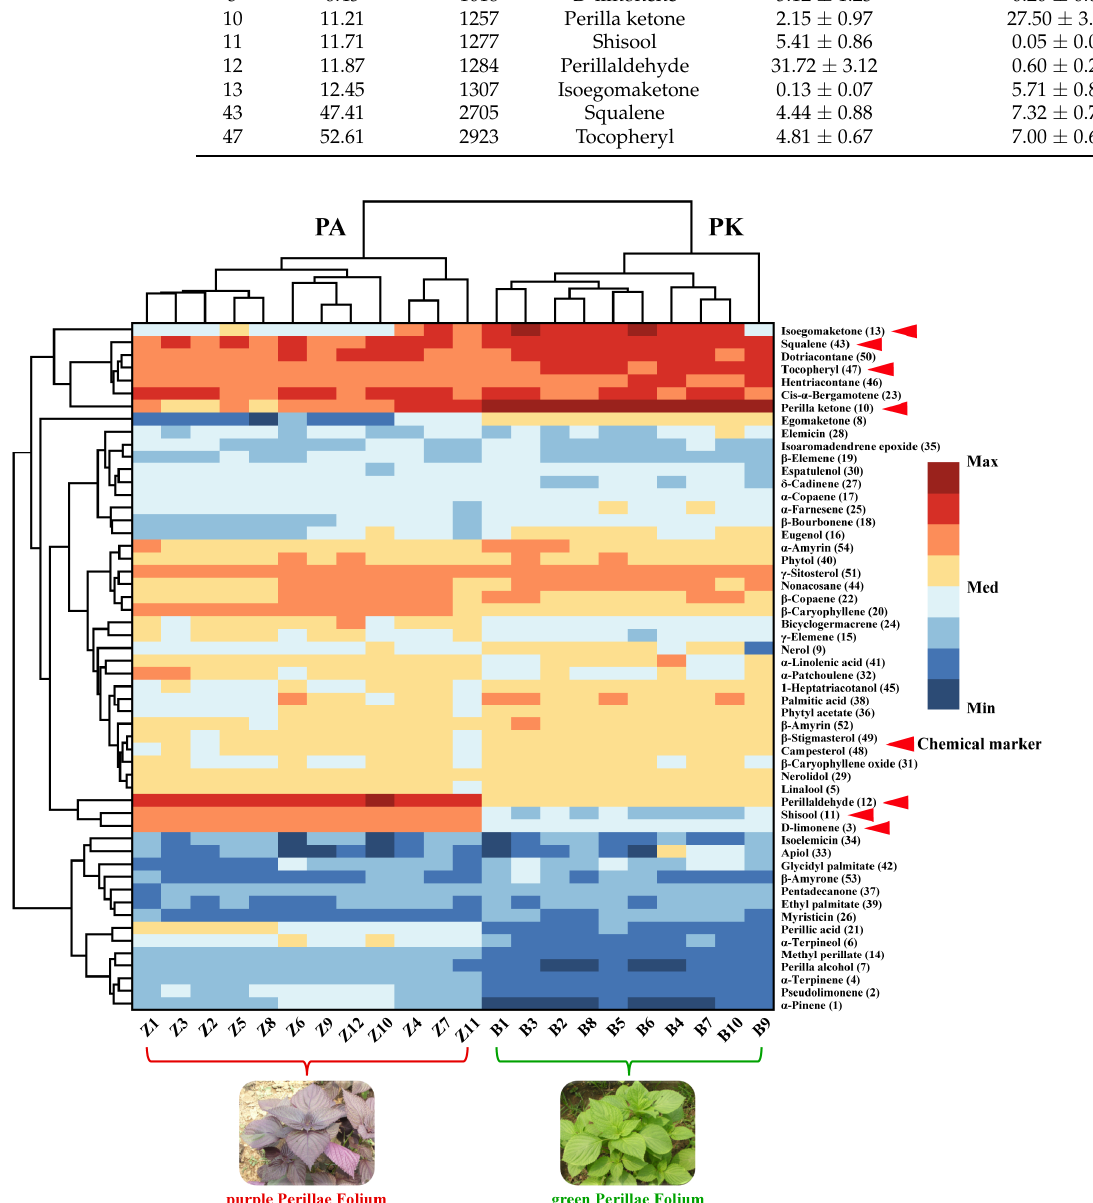
Figure 3. The relative concentration trends of identified compounds in purple PF and green PF.